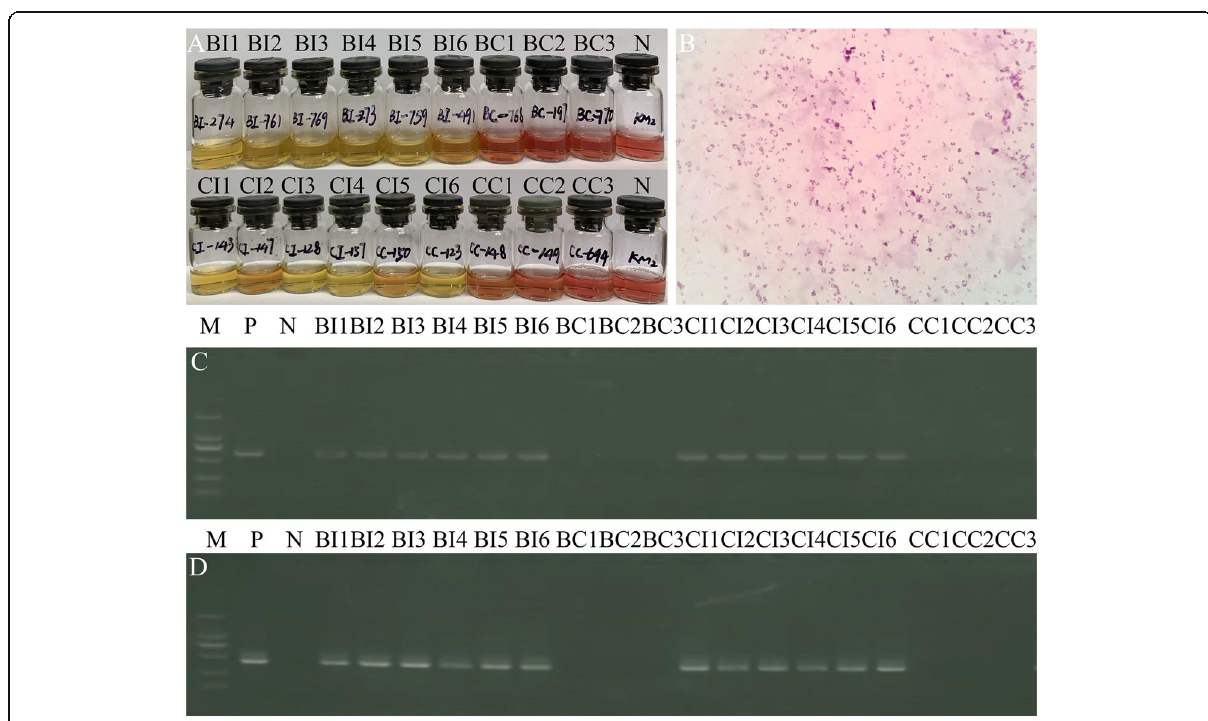
Fig. 7 Re-isolation and identification of M. hyopneumoniae from BALF of all pigs. a Growth condition and colour observation of samples re- isolated from the BALF of all pigs after 120 h of culture at 37 °C. Infected group of Bama miniature pigs (BI): BI1, BI2, BI3, BI4, BI5, BI6; Control group of Bama miniature pigs (CI): BC1, BC2, BC3; Infected group of conventional pigs (CI): CI1, CI2, CI3, CI4, CI5, CI6; Control group of conventional pigs (CC): CC1, CC2, CC3; N: KM2 culture medium of M. hyopneumoniae . b BALF cultures after colour change and pH value between 6.5 – 6.8 after tested were collected, and cultures among infected groups of Bama miniature pigs (BI) and infected groups of conventional pigs (CI, data not shown) were subjected to Wright ’ s staining and electron microscopic observation at 1000 × magnification. M. hyopneumoniae mainly displayed ring-shaped, spherical, bipolar, crescent, filamentous, and other mycoplasma-like cells. c and d Nested PCR test of P36 for re-isolated M. hyopneumoniae of passage 2 using specific outer and inner primers, respecively. M, DNA 2000 marker; P, positive control; N, negative control; Infected group of Bama miniature pigs (BI): BI1, BI2, BI3, BI4, BI5, BI6; Control group of Bama miniature pigs (BC): BC1, BC2, BC3; Infected group of conventional pigs (CI): CI1, CI2, CI3, CI4, CI5, CI6; Control group of conventional pigs (CC): CC1, CC2, CC3; the amplified product sizes of outer and inner product were 621 bp and 427 bp,